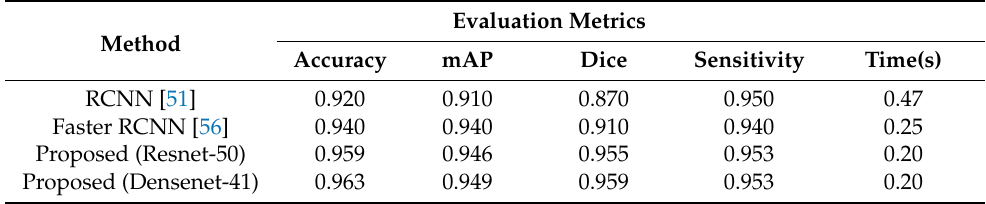
Figure 11. Confusion matrix of the presented technique using DenseNet-41. ( a ) Figshare Brain Tumor Dataset, ( b ) Brain MRI Dataset. Table 2. Performance comparison of our technique with other RCNN